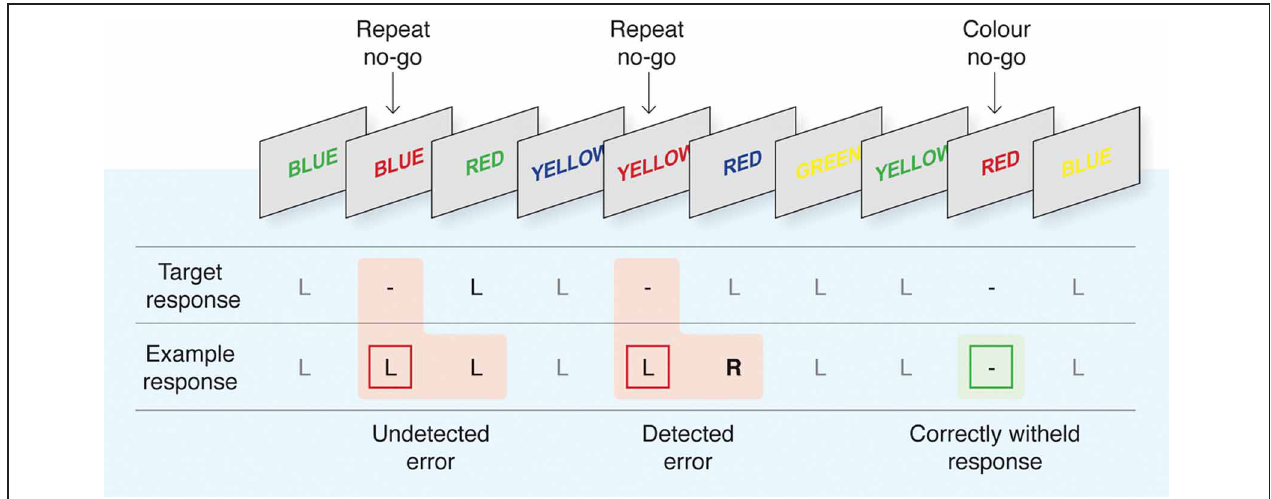
FIGURE 1 | The Error Awareness Task (EAT). The EAT presents a serial stream of single color words in colored fonts. Participants were trained to respond to each of the words with a single “Go trial” button press, and to withhold this response when either of two different circumstances arose. The first was if the same word was presented on two consecutive trials (Repeat No-go), and the second was if the word and font of the word matched (Color No-go). To indicate “error awareness” participants were trained to forego the